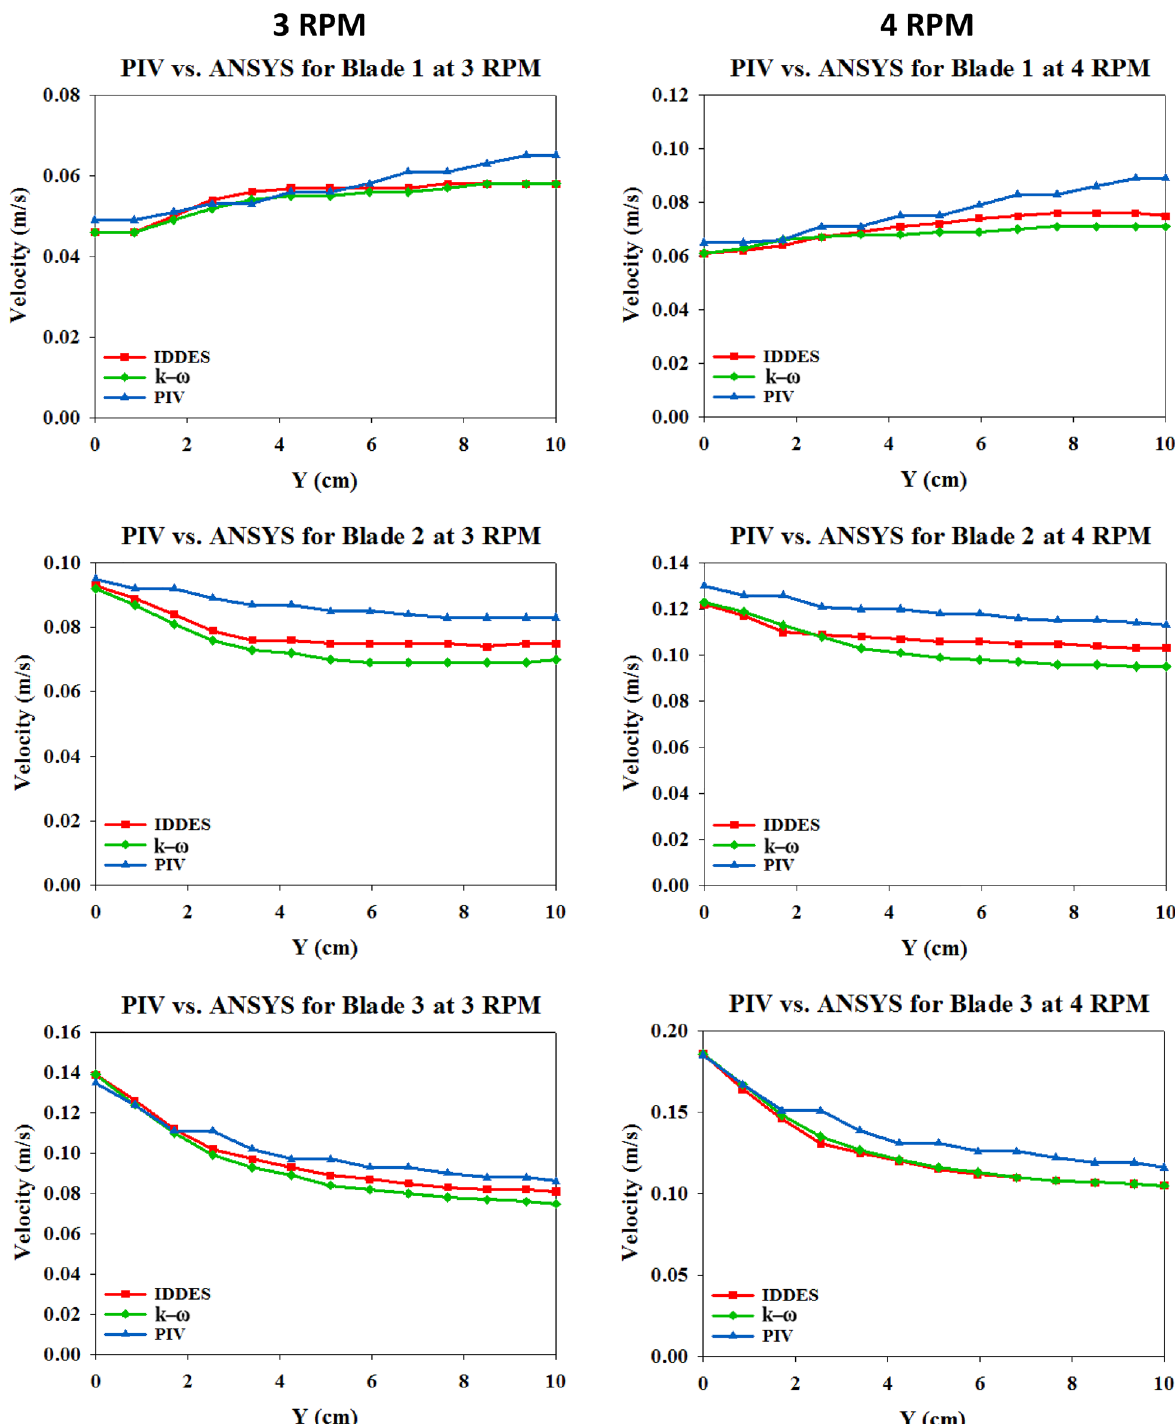
Figure 10. Comparison of PIV and ANSYS-fluent velocity variation above blade